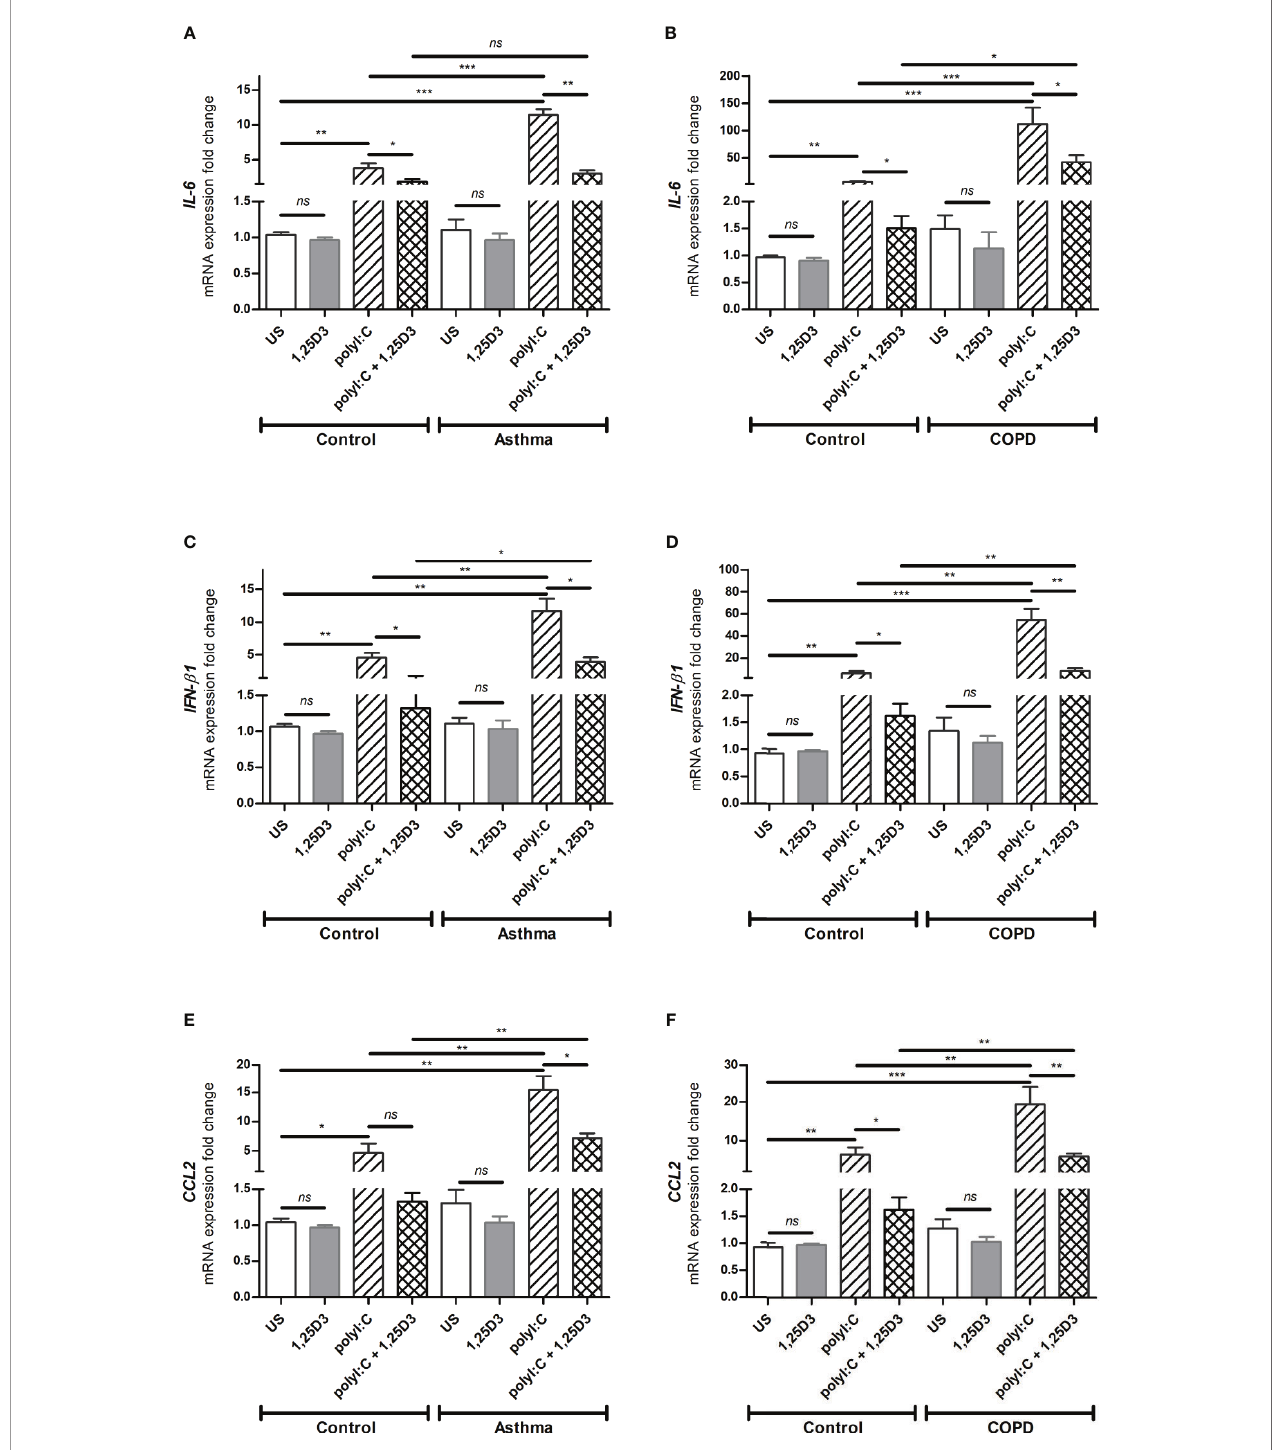
FIGURE 3 | mRNA expression of IL-6 (A, B) , IFN- b 1 (C, D) and CCL2 (E, F) in BSMCs from severe asthma (A, C, E) and mild COPD (B, D, F) compared to BSMCs from healthy control groups. n = 4 asthma, n = 3 healthy controls, n = 4 COPD, and n = 3 healthy control smokers. qRT-PCR data is representative of two independent experiments. One way ANOVA using Newman-Keuls multiple comparison test were performed to assess statistical signi fi cance between groups. Mean ± SE; ( ns ) p > 0.05, no signi fi cant difference, * p < 0.05, ** p < 0.01, *** p <